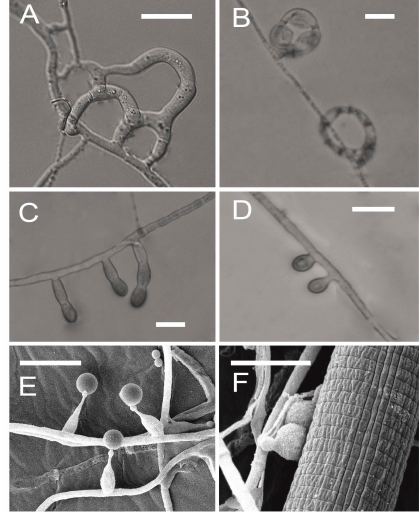
Figure 1. Morphology of traps and adhesive conidia produced by nematophagous fungi: ( A ) Adhesive nets ( Arthrobotrys oligospora ); ( B ) Constricting rings ( Drechslerella stenobrocha ); ( C ) Adhesive columns ( Gamsylella cionopaga ); ( D ) Adhesive knobs ( Gamsylella robusta ); and ( E , F ) Adhesive conidia ( Hirsutella minnesotensis ). Bars = 10 μ m.